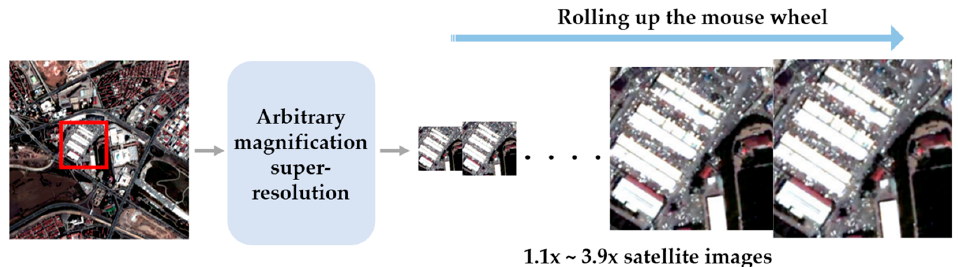
Figure 3. Example application of arbitrary magnification super-resolution in satellite image processing task.